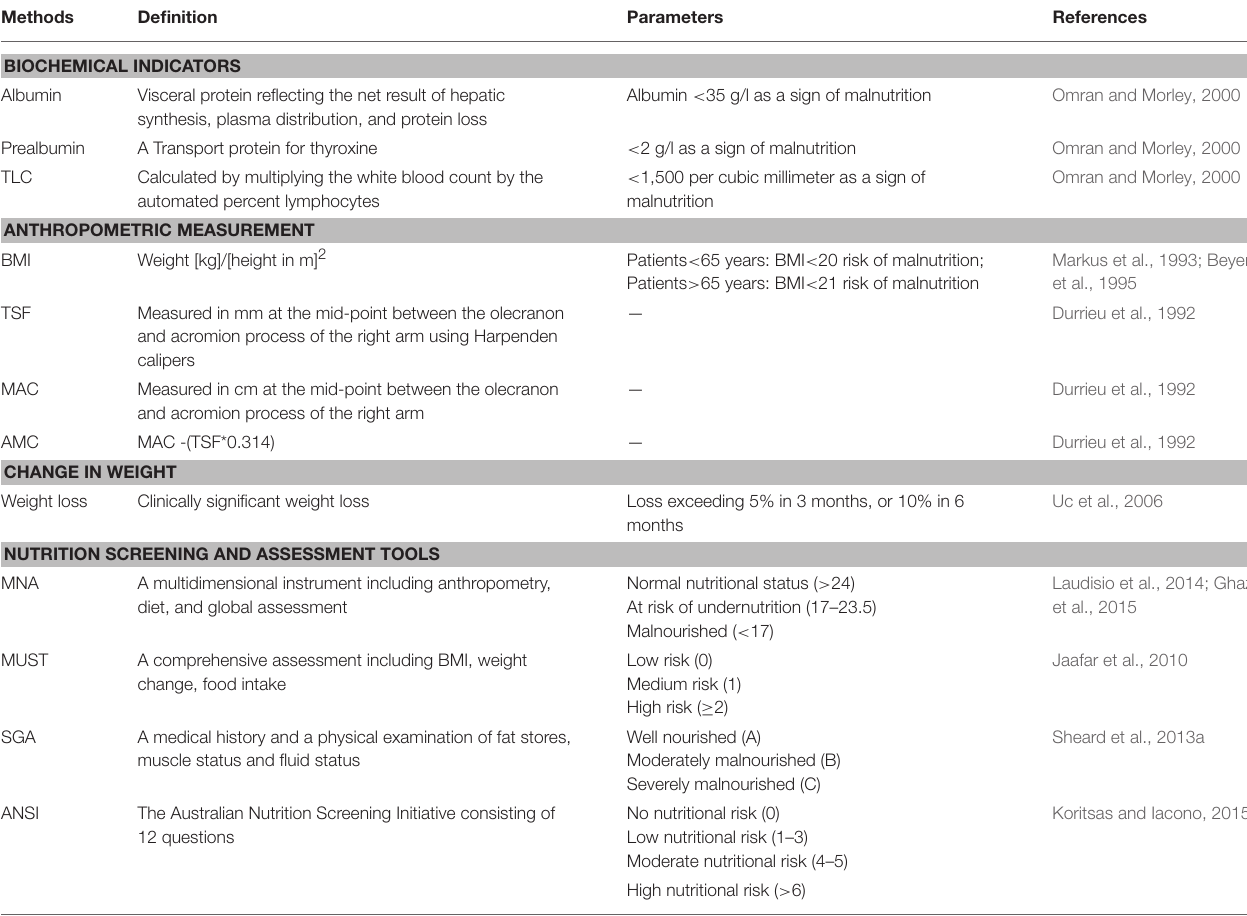
TABLE 2 | Nutritional assessment measures available at